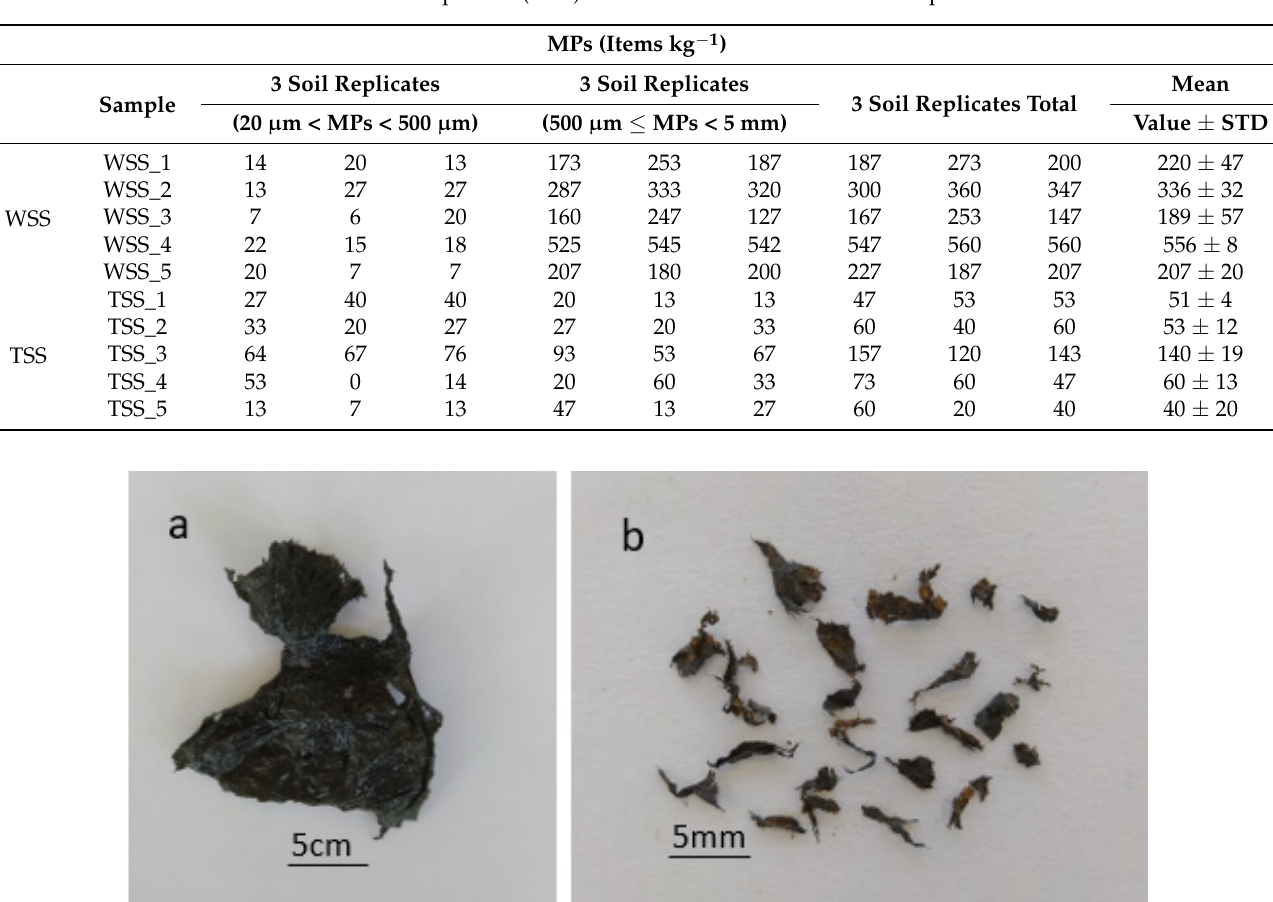
Figure 2. Pictures of used black plastic mulch ( a ) and microplastics ( b ) detected on the investigated agricultural areas.